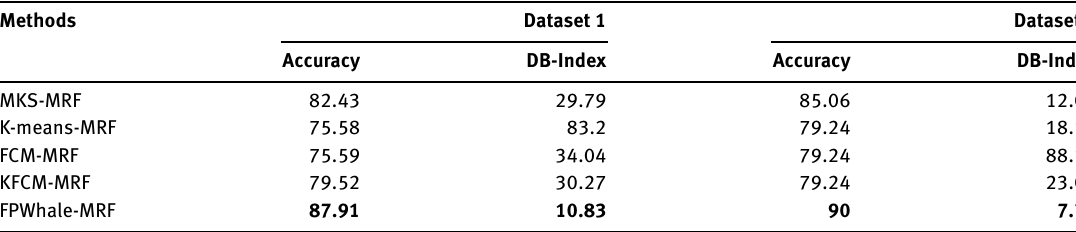
Table 3: Performance Comparison Based on Maximum Performance.